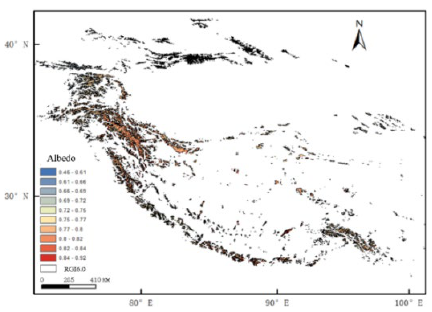
Figure 3. Sentinel-3 inversion of albedo of High mountain glaciers in Asia on April 2017.